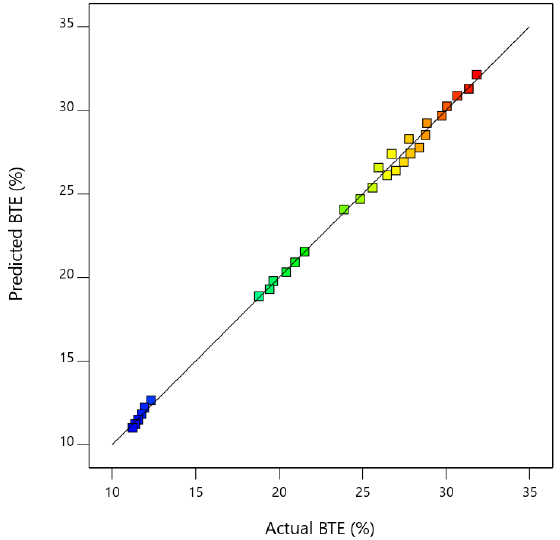
Figure 2. ( a ) Contour plot and ( b ) response surface of BTE.